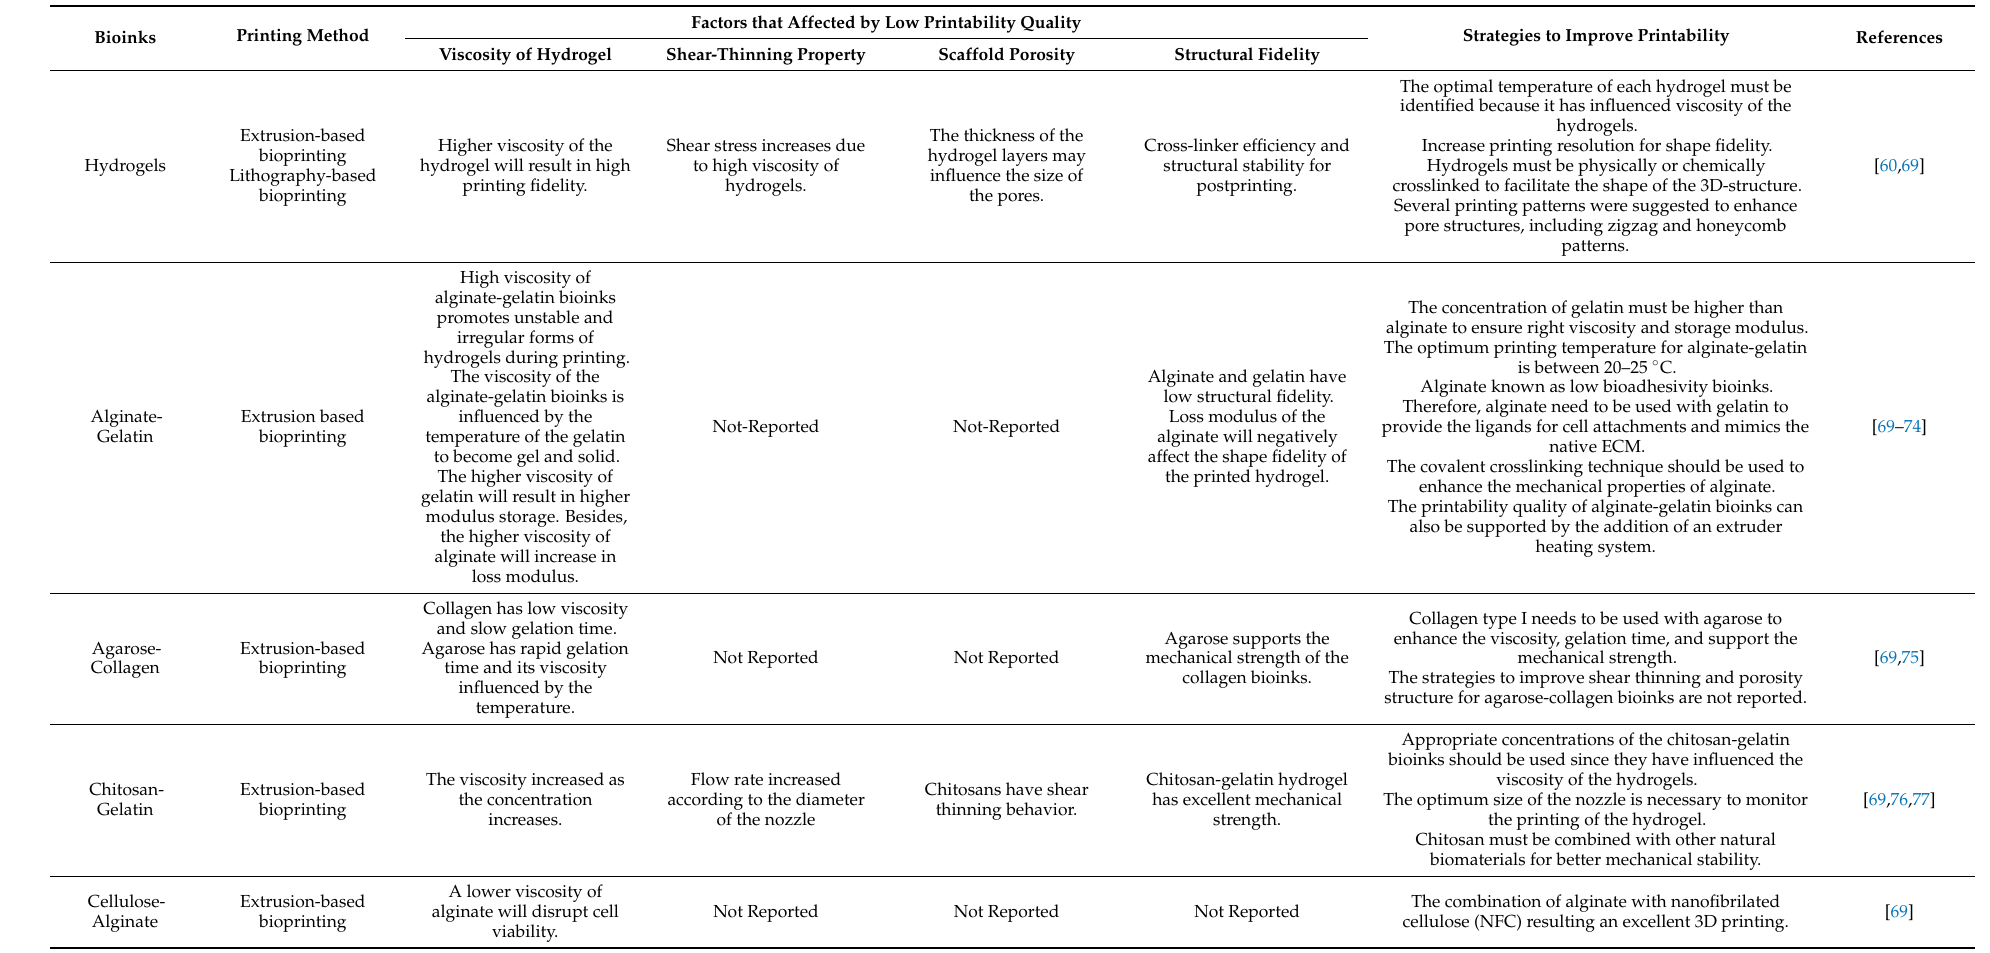
Table 5. The factors that were affected by low printability quality in 3D-bioprinting